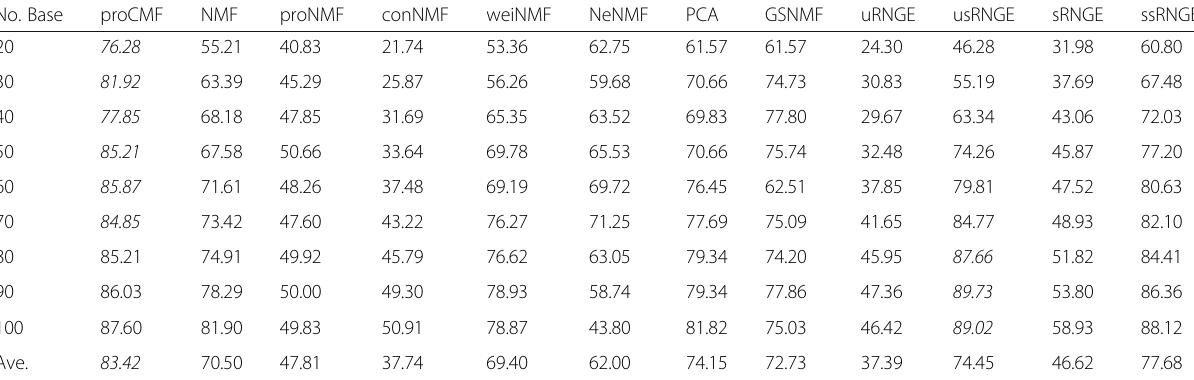
Table 6 Facial expression recognition rate (%) using the occluded CK+ with different subspace dimensionalities (case of occluded mouth) No. Base 81.92